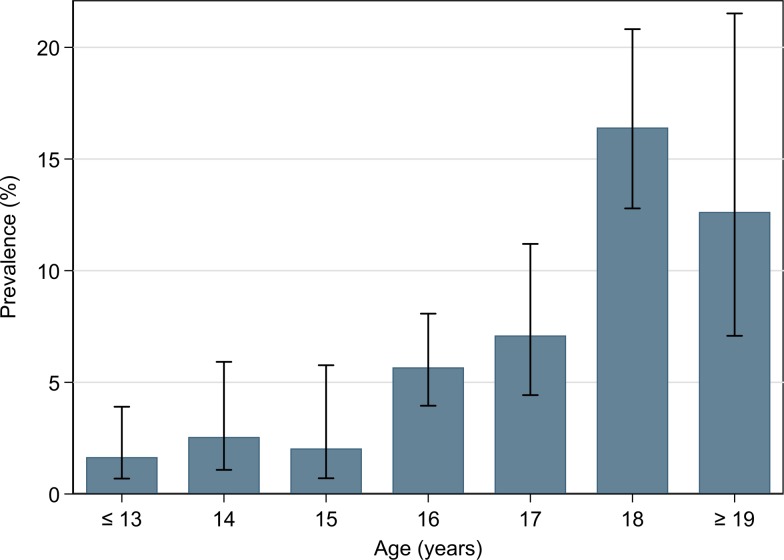
Prevalence of carriers of N. meningitidis by age (n = 2296; carriers of N. meningitidis n = 167). Error bars indicate 95% confidence intervals.